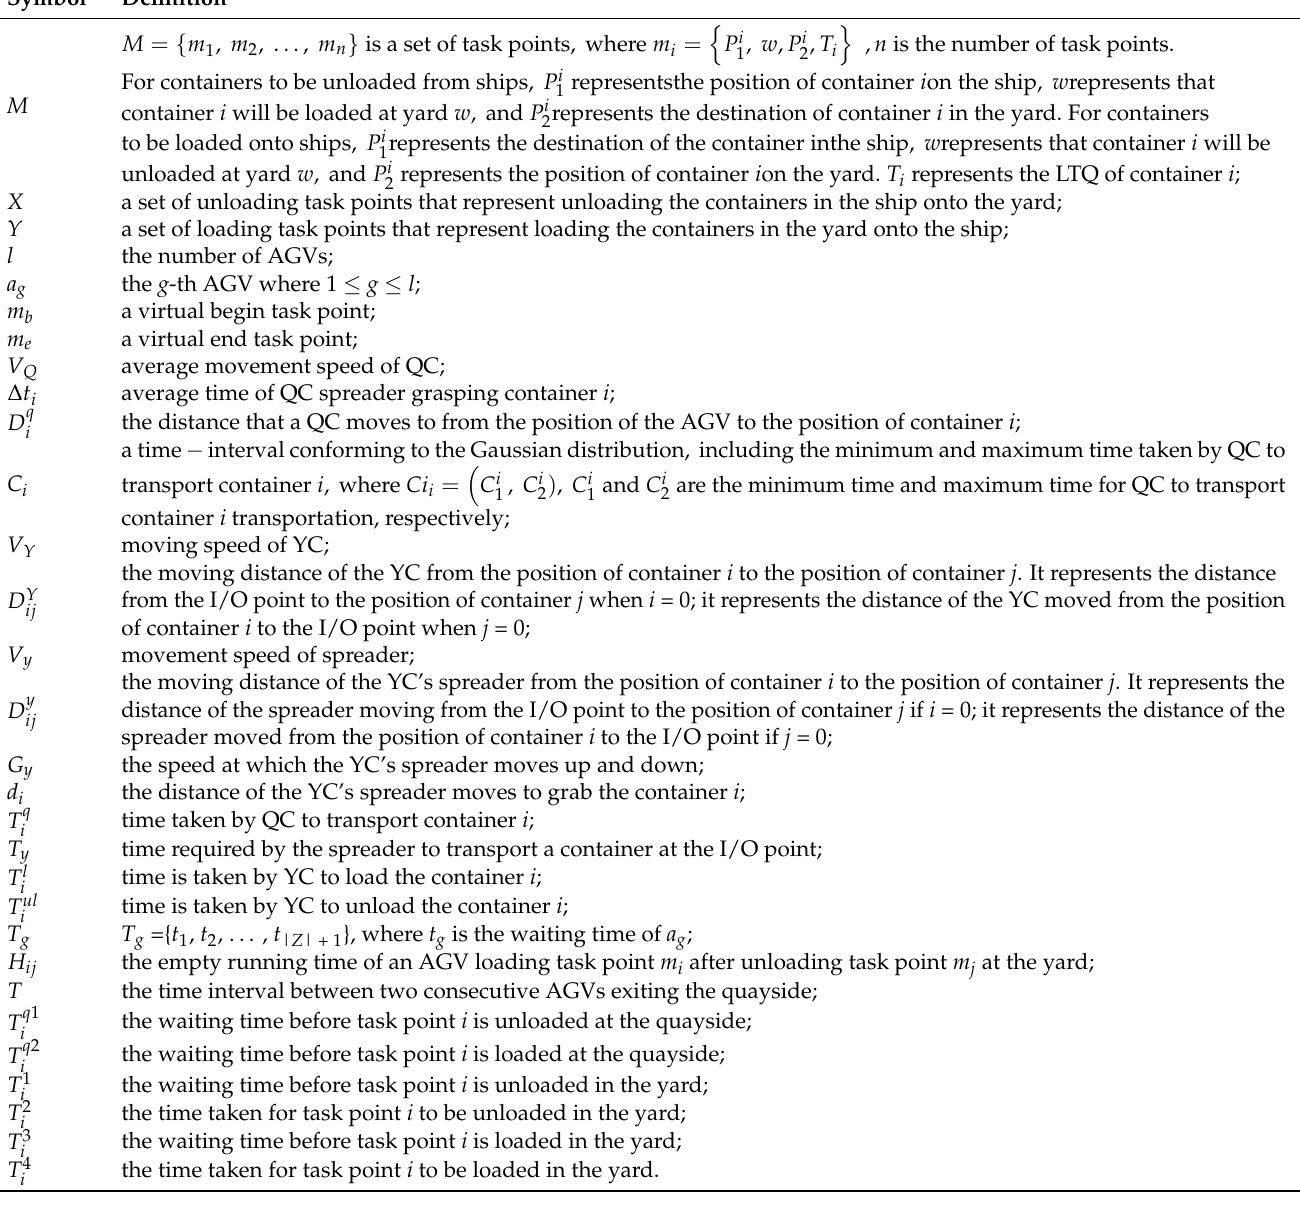
Table 2. The symbols and their